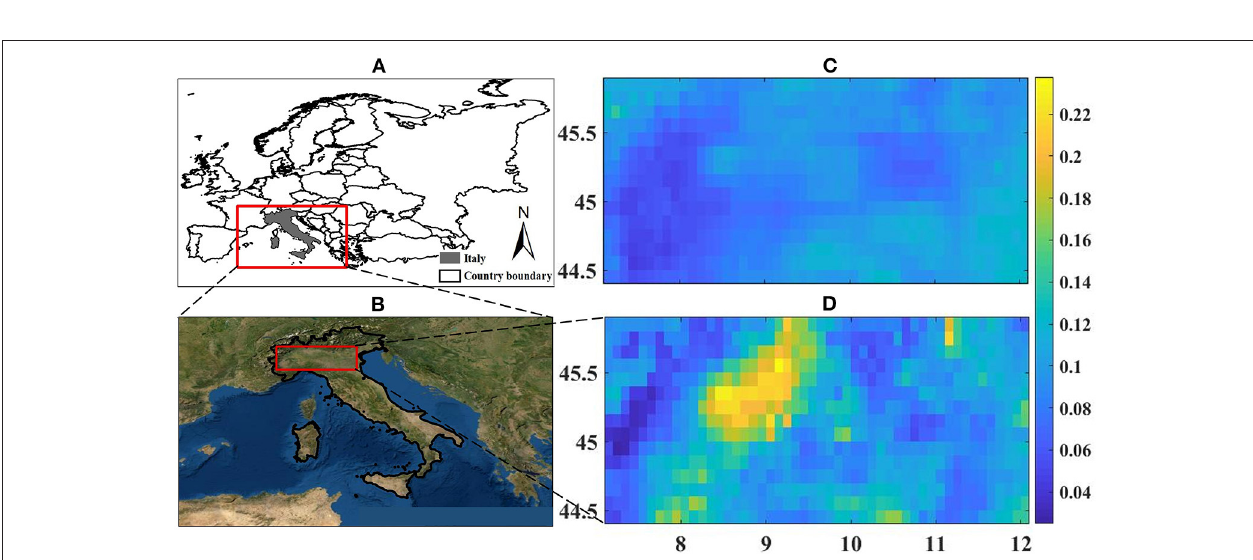
FIGURE 2 | (A) Location of the study area in Italy; (B) Boundaries of the study areas in Northern Italy overlying the “World Imagery” ArcGIS Online basemap (Sources: Esri, DigitalGlobe, GeoEye, i-cubed, USDA FSA, USGS, AEX, Getmapping, Aerogrid, IGN, IGP, swisstopo, and the GIS User Community); (C) Average IMERG precipitation in mm/hour during January-April of 2001-2019; and (D) Average IMERG precipitation in mm/hour during January-April 2020.